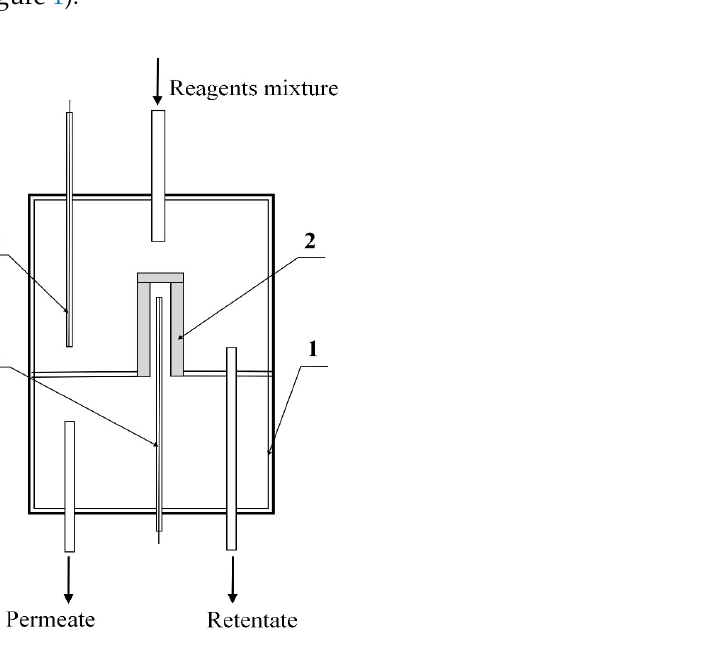
Figure 1. Schematic diagram of a reactor with a membrane catalyst: 1—membrane reactor, 2— membrane catalyst, 3, 4—thermocouples that control temperatures outside (in the shell side of reactor) and inside (tube side) of membrane catalyst.